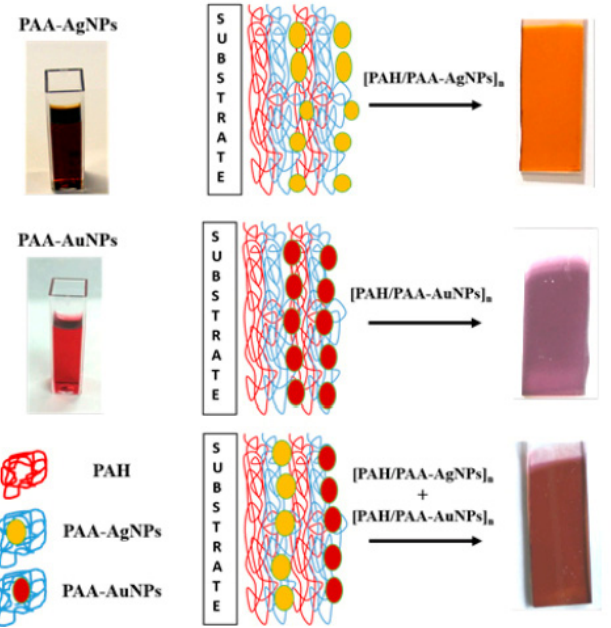
Figure 9. Aspect of the silver nanoparticles (PAA-AgNPs) and gold nanoparticles (PAA-AuNPs) with a schematic summary for their incorporation into LbL films. Reprinted with permission of